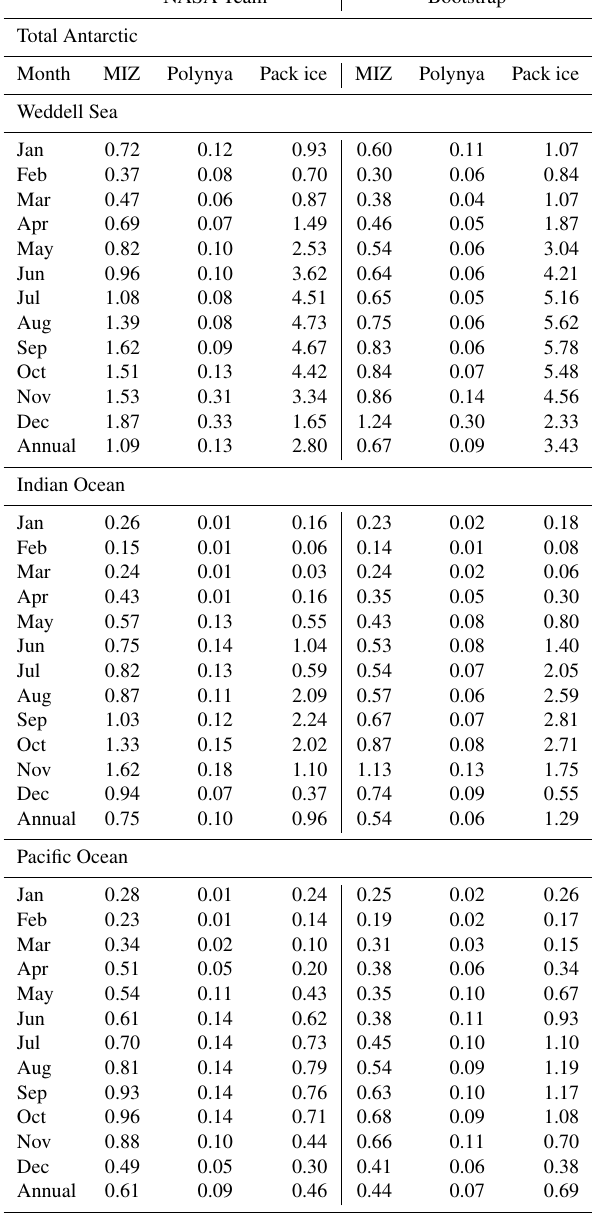
Table 2. Monthly-mean extents of the different ice classes. Values are only listed for the consolidated pack ice, the marginal ice zone and the potential coastal polynya area. Values are listed in 10 6 km 2